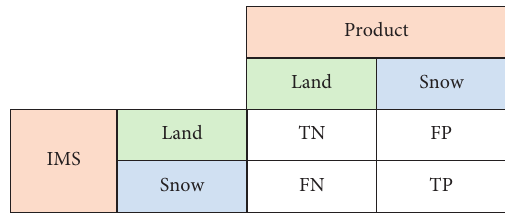
Figure 3: Classification used in the intercomparison of snow cover products, where product refers to either MSPPS or MIRS.